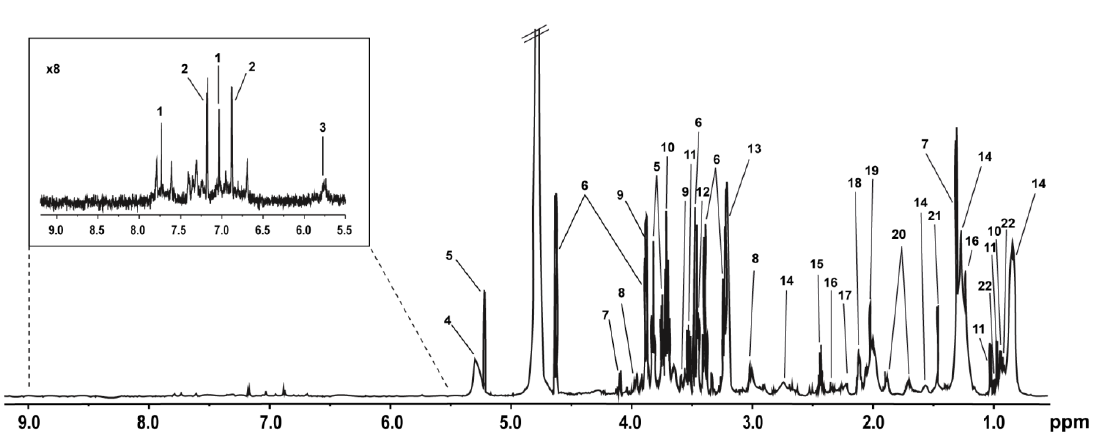
Figure 1. 1 H NMR CPMG spectrum of human blood serum from a patient suffering from IBS. The key is given in Table